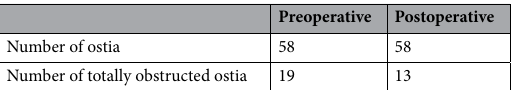
Table 2. The number of measured ostia (number of patients